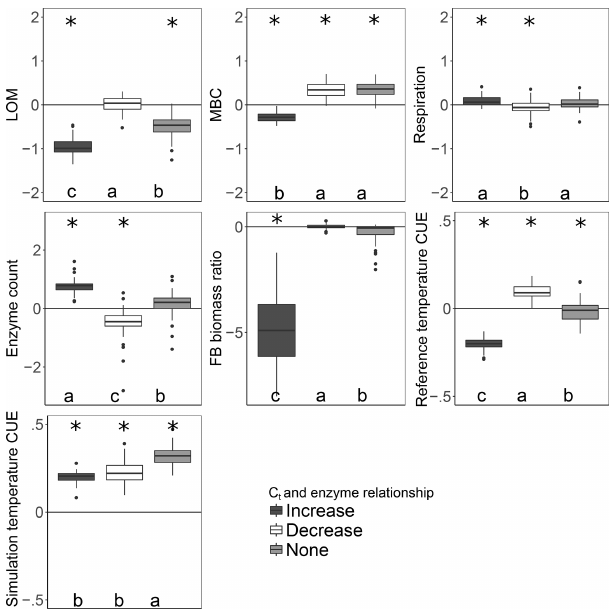
Figure 4. Effect of warming 5 ◦ C on C stocks and flows in simu- lations, reported as the natural log of the ratio of values in heated compared to control conditions. The CUE temperature response was forced to increase, decrease, or remain independent of the number of enzymes a taxon could produce. Values above the zero line in- dicate that warming increased the value, and values below indicate a decrease with warming. Boxplots denote the first to third quar- tiles with the median. Asterisks denote a significant warming effect at P < 0 . 0001 after correcting for multiple comparisons using the Bonferroni method. Letters denote warmed scenarios which are sig- nificantly different from one another using the same criteria. “Refer- ence temperature CUE” denotes the ratio of CUE for the surviving community at 15 ◦ C in the warmed scenarios to the ratio of CUE for the surviving community at 15 ◦ in the control scenarios, while “simulation temperature CUE” denotes the ratio of CUE in heated scenarios run at 20 ◦ C to control scenarios run at 15 ◦